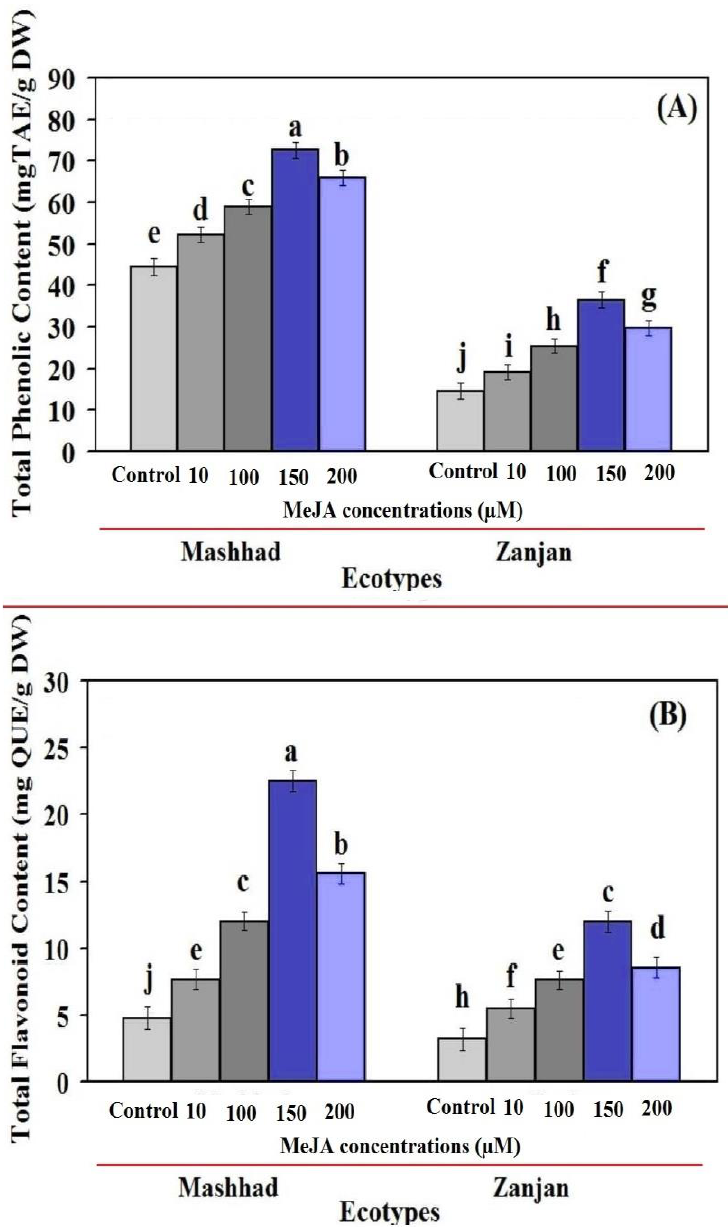
Figure 3. The impact of various MeJA concentrations on the TPC ( A ) and TFC ( B ) of leaf extracts from two Iranian coriander ecotypes. The data are shown as mean standard deviations (n = 3). According to Duncan’s test, distinct letters in each column indicate significance at a 1% level of probability. Error bars are shown in percent of standard